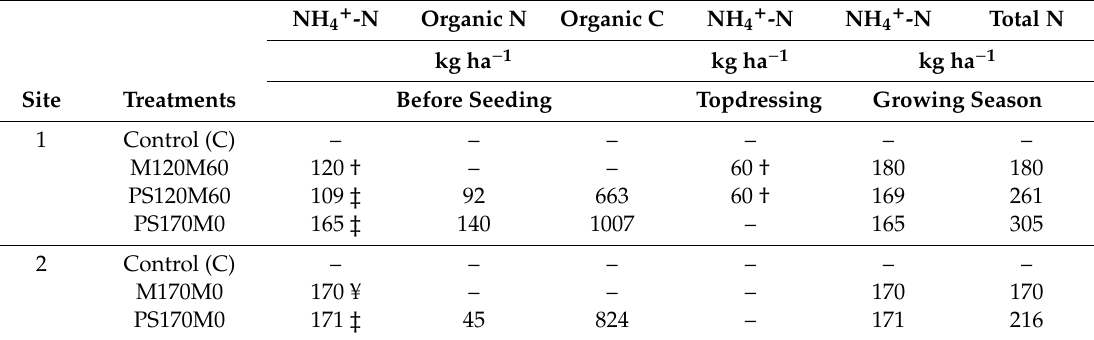
Table 2. N fertilization treatments in the two experimental sites. N rates for pig slurry (PS) treatments are the actual N rates applied in the